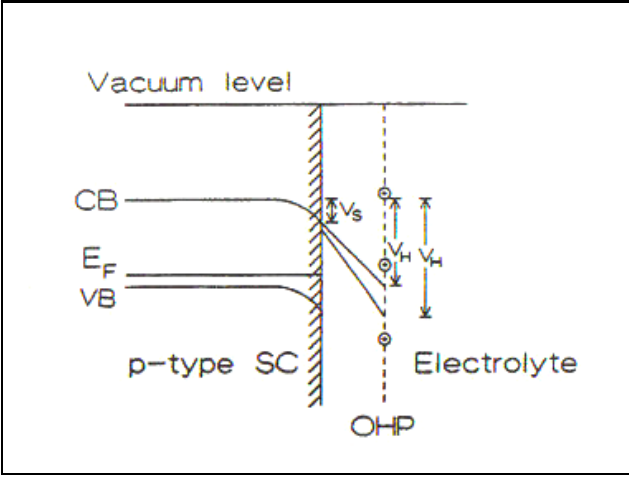
Figure 5. p -Type semiconductor/solution interface in the presence of high-density surface states. The potential difference in the Helmholtz part of the double layer, ( i.e. , that in the solution) is greatly increased compared with a situation with a negligible number of surface states. Correspondingly, the potential difference within the semiconductor is greatly diminished compared with one containing negligible surface states (Reprint from